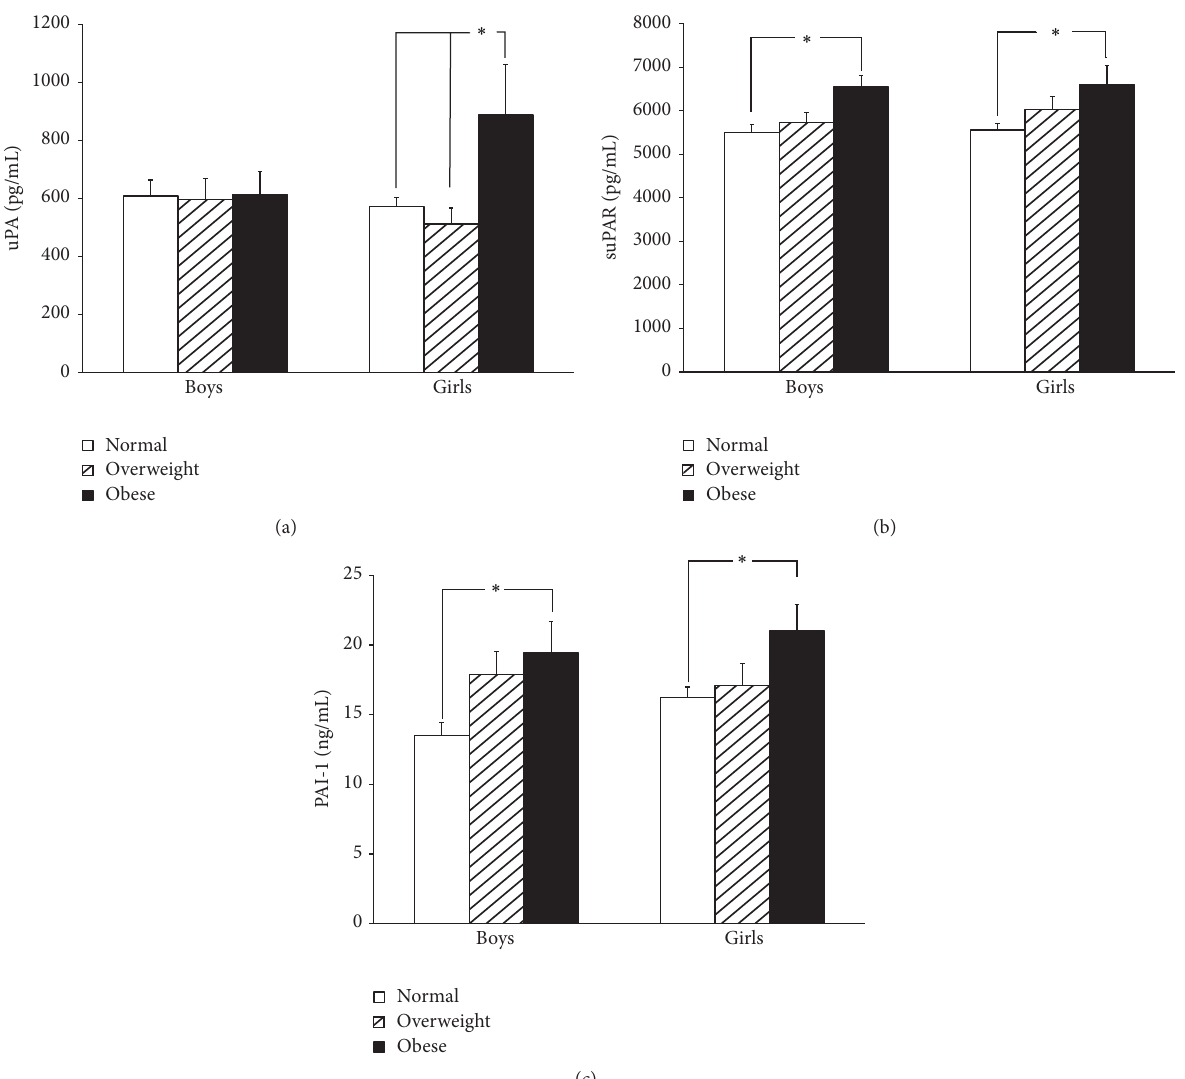
Figure 1: (a) Urokinase plasminogen activator (uPA), (b) soluble urokinase plasminogen activator receptor (suPAR), and (c) plasminogen activator inhibitor-1 (PAI-1) in normal, overweight, and obese children. The uPA levels in obese girls are higher than in overweight and normal girls. In addition, suPAR and PAI-1 levels in the obese children are higher than in the normal group in both genders. Mean ± SE; ∗ 𝑃 < 0.05 .